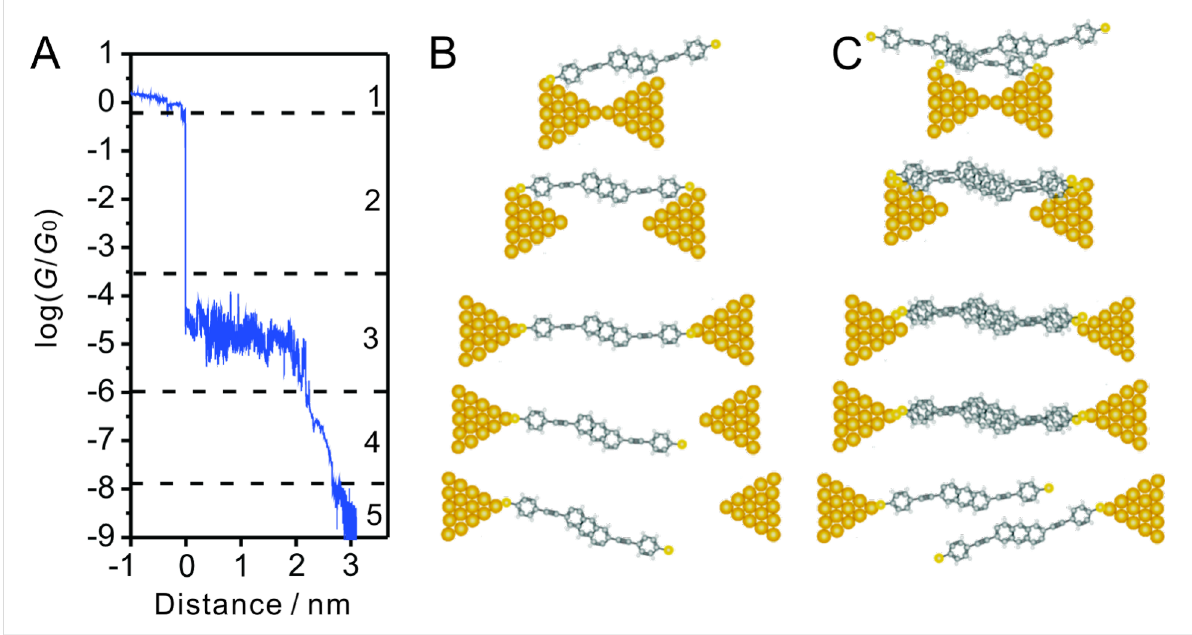
Figure 10: Model of the breaking process of the Au| AC |Au junction. (A) A typical trace with labels indicating various stages of the process. (B) Model of the formation and breaking of a single-molecule junction. (C) Model for a scenario involving the stacking of two molecules.